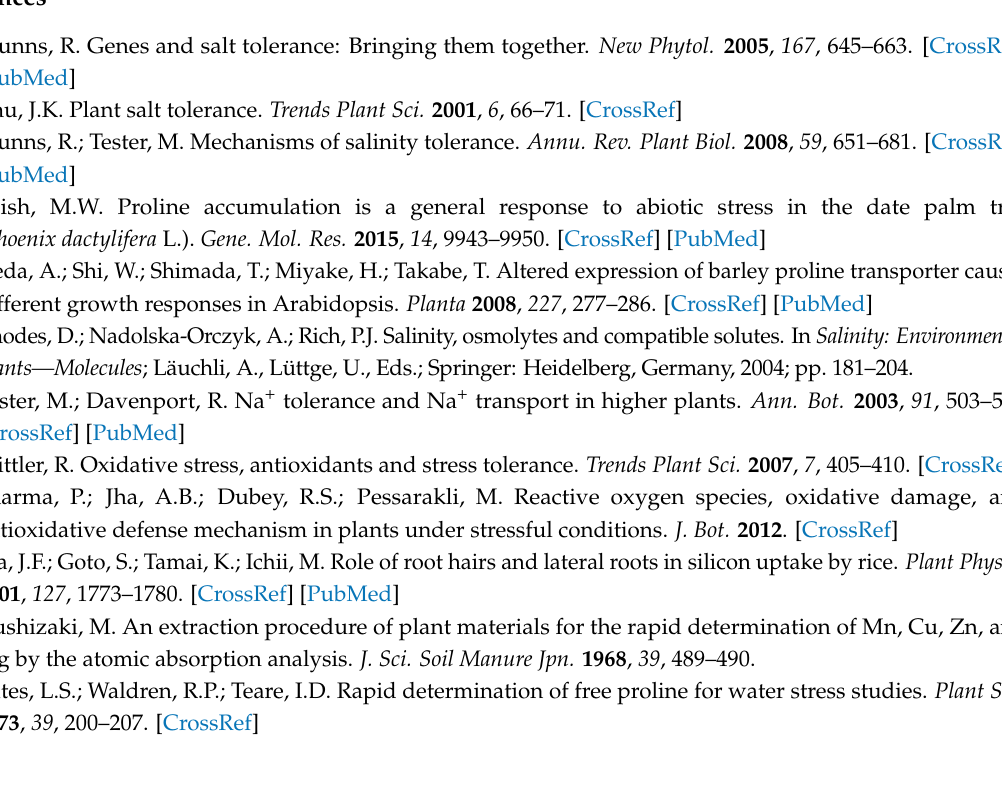
Figure S1: Visual symptoms of salt injury of different rice varieties after 14 day treatment; Figure S2: Effect of salinity stress (100 mM NaCl) on root and shoot lengths of Sakha 103, Sakha 104, Sakha 105, Sakha 106, Giza 182, and Pokkali varieties after 14 day treatment. Data represent means ± SE ( n = 4). Similar letters in a bar indicate no significant difference ( p ≤